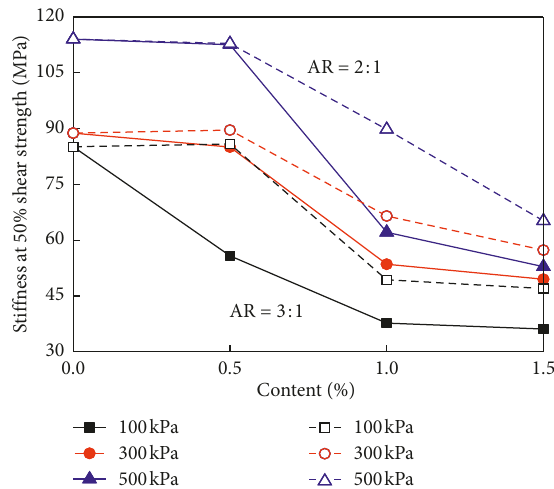
Figure 5: Variations in brittleness index under the effects of fabric block content and aspect ratio.